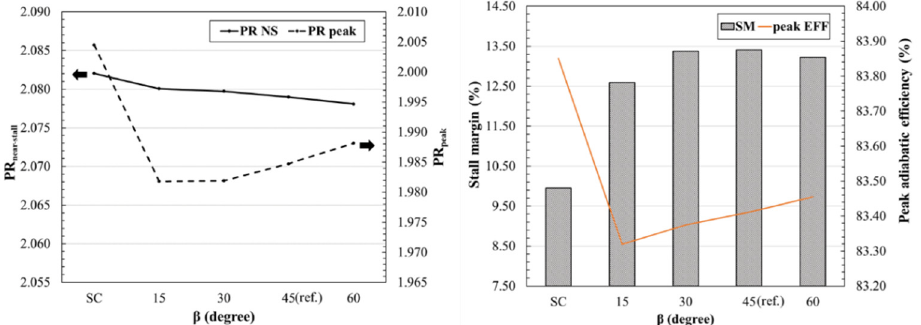
Figure 15. Effects of rear bleed angle on performance.